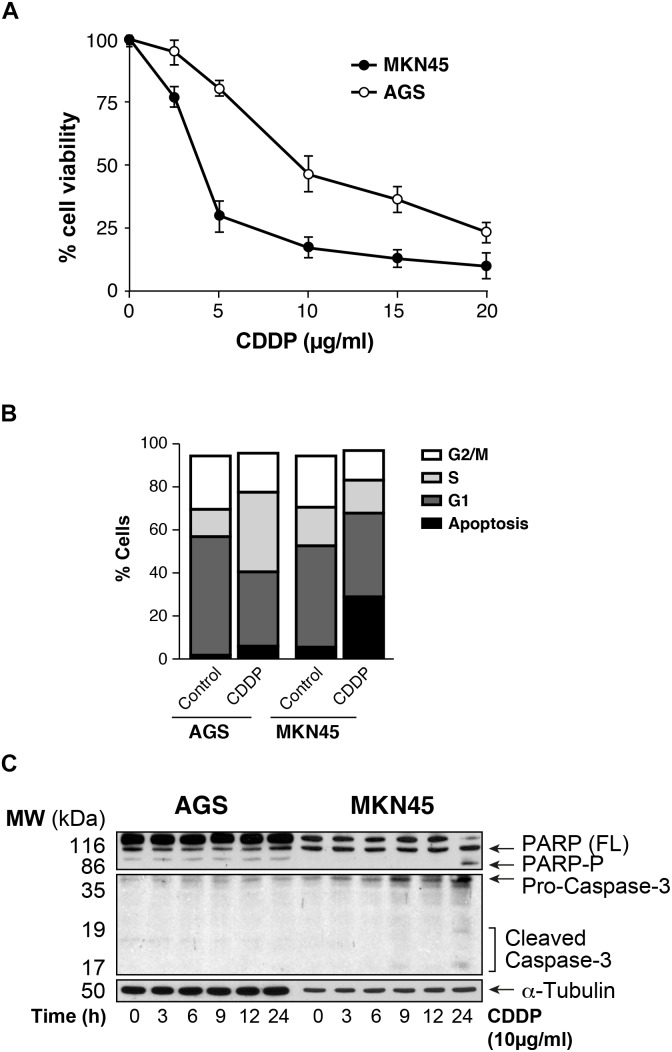
AGS and MKN45 show different sensitivity to CDDP. (A) Cell survival percentage of AGS and MKN45 cells after 72 h of CDDP treatment. Cells were treated with increasing concentrations of CDDP (0–20 μg/ml). The percentage of viable cells was quantified by the crystal violet method. Data represent the mean values obtained in three experiments performed in quadruplicate. (B) Cell cycle profile of AGS and MKN45 cells after 24 h of CDDP treatment (10 μg/ml). DNA content was assessed by flow cytometry, and cell cycle distribution was analyzed using Cell Quest Pro software. The graph shows the percentage of each cell cycle, which is given as the mean ± standard deviation of three experiments. G2/M, cells in G2 or Mitosis; S, cells in phase of synthesis of DNA; G1, cells in G1. (C) Cleavage of PARP-1 and Caspase-3 activation were detected by western blot (WB) in cells harvested at the indicated times after CDDP treatment (10 μg/ml). α-Tubulin was used as loading control. WB images are representative of the results obtained in three different experiments made in the same conditions.